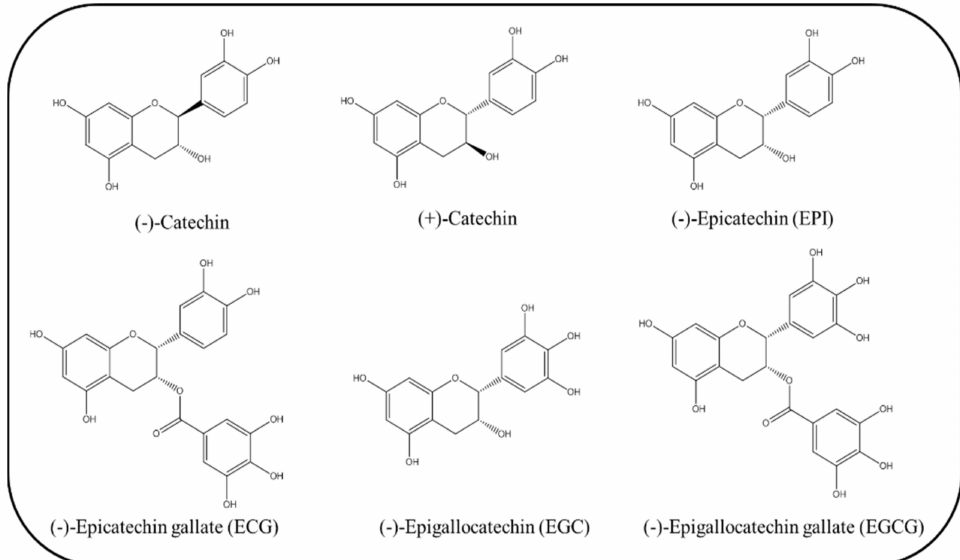
Figure 1. The chemical structures of major catechin